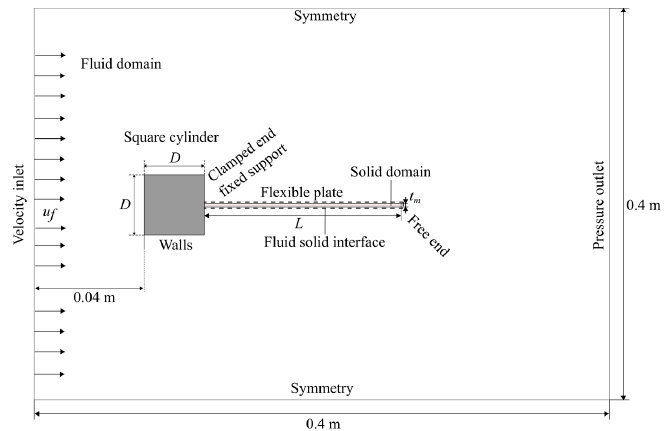
Figure 5. Boundary conditions for the fluid and solid domain.